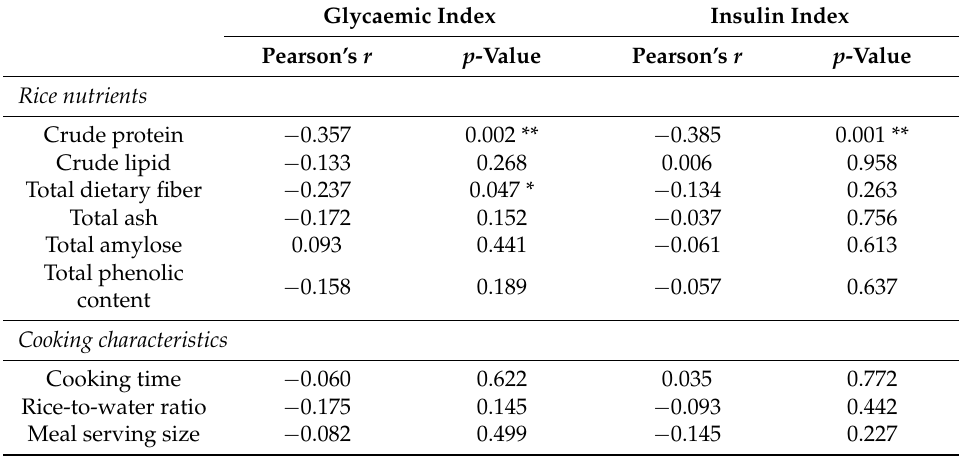
Table 3. Correlation between nutrient content, cooking characteristics, glycaemic and insulin indices of test